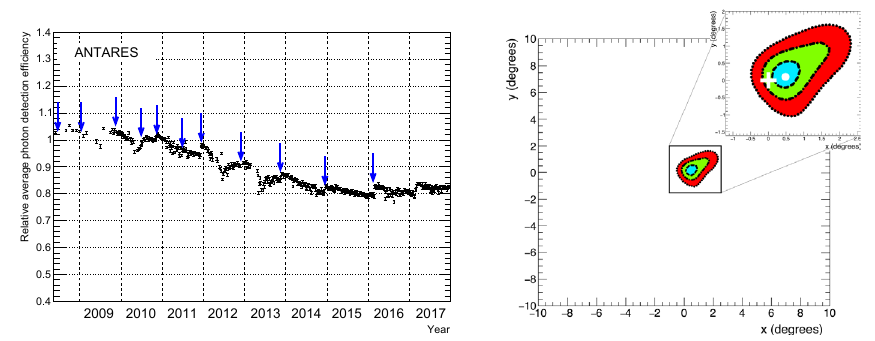
Figure 1. Left: Relative OM e ffi ciency averaged over the whole detector against time. The blue arrows indicate the periods in which high voltage tunings of the PMTs has been performed, while error bars indicate the statistical error on the mean e ffi ciency. Right: Moon shadow. Contour plots corresponding to di ff erent confidence levels (68.27% ; 95.45% ; 99.73% ). The dot represents the most significant position, while the cross indicates the nominal position of the Moon, i.e. the center of the FoV.